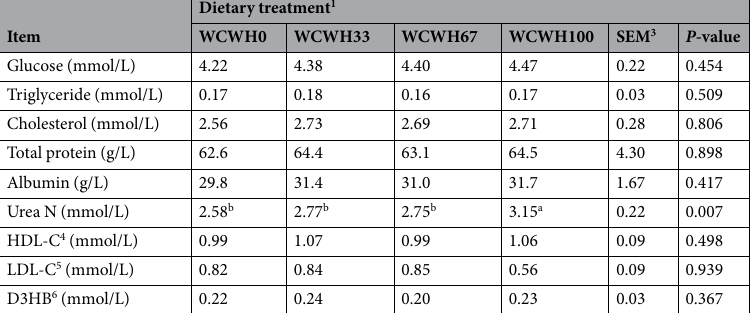
Table 2. The effects of dietary treatments on plasma biochemical parameters of Holstein dairy bulls during the fattening period 1,2 . 1 WCWH0 = 0% of Leymus chinensis was replaced by whole-crop wheat hay; WCWH33 = 33% of Leymus chinensis was replaced by whole-crop wheat hay; WCWH67 = 67% of Leymus chinensis was replaced by whole-crop wheat hay; WCWH100 = 100% of Leymus chinensis was replaced by whole-crop wheat hay. 2 a–b: Means within the same row without the same letter superscripts are significantly different (Tukey’s test; P < 0.05). 3 SEM: Standard error of the mean. 4 High density lipoprotein cholesterol. 5 Low density lipoprotein cholesterol. 6 β -Hydroxybutyrate.